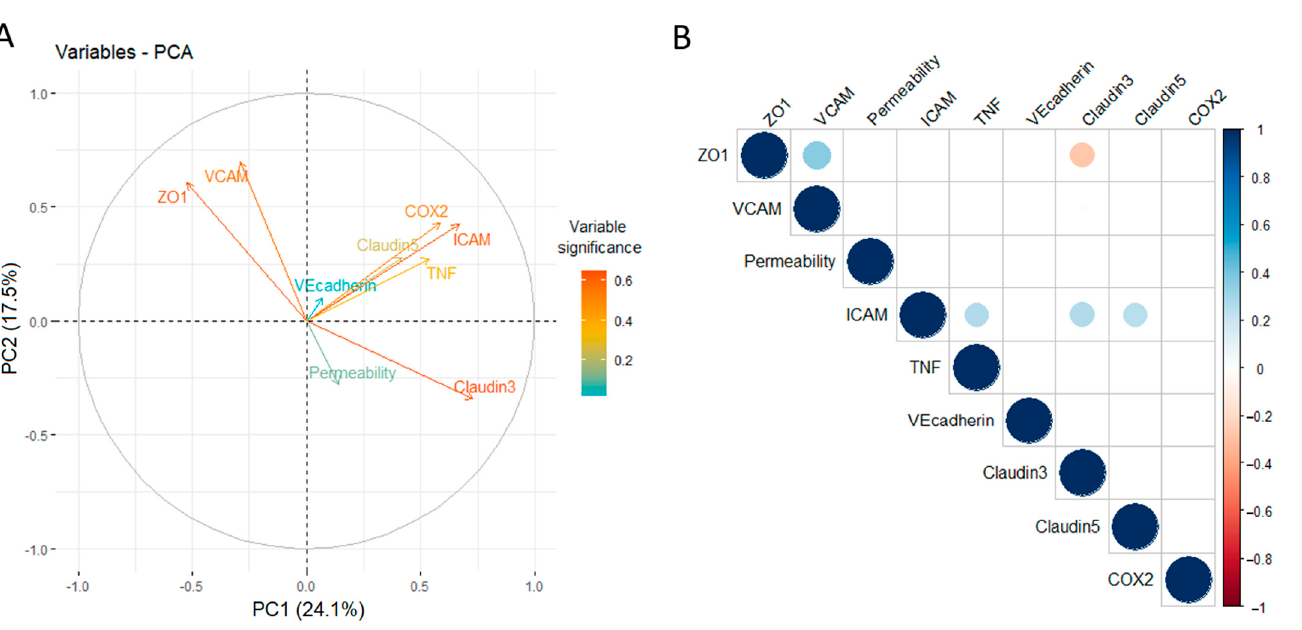
Figure 2. Exploratory analysis of data generated from treatment of BLECs with donor plasma. Plasma was obtained from n = 30 IBD patients and 30 healthy donors matched by age and sex. BLECs were treated with 10% plasma for 24 h and permeability to NaFlu, and expression of proteins by Western blotting were assessed. PCA of these parameters alongside TNF α levels in donor plasma was carried out, and loading plots of assessed parameters are shown (heat scale at the side of the graph indicate numerical significance to the model of the assessed parameters) ( A ). A correlation matrix correlating all assessed parameters was also generated (only correlations of p value < 0.05 are shown, this being represented by circles of larger size, the smaller the p value is; the heat-scale at the side of the graph indicates in blue whether significant correlations are positive or in red in case correlations are negative) ( B ).